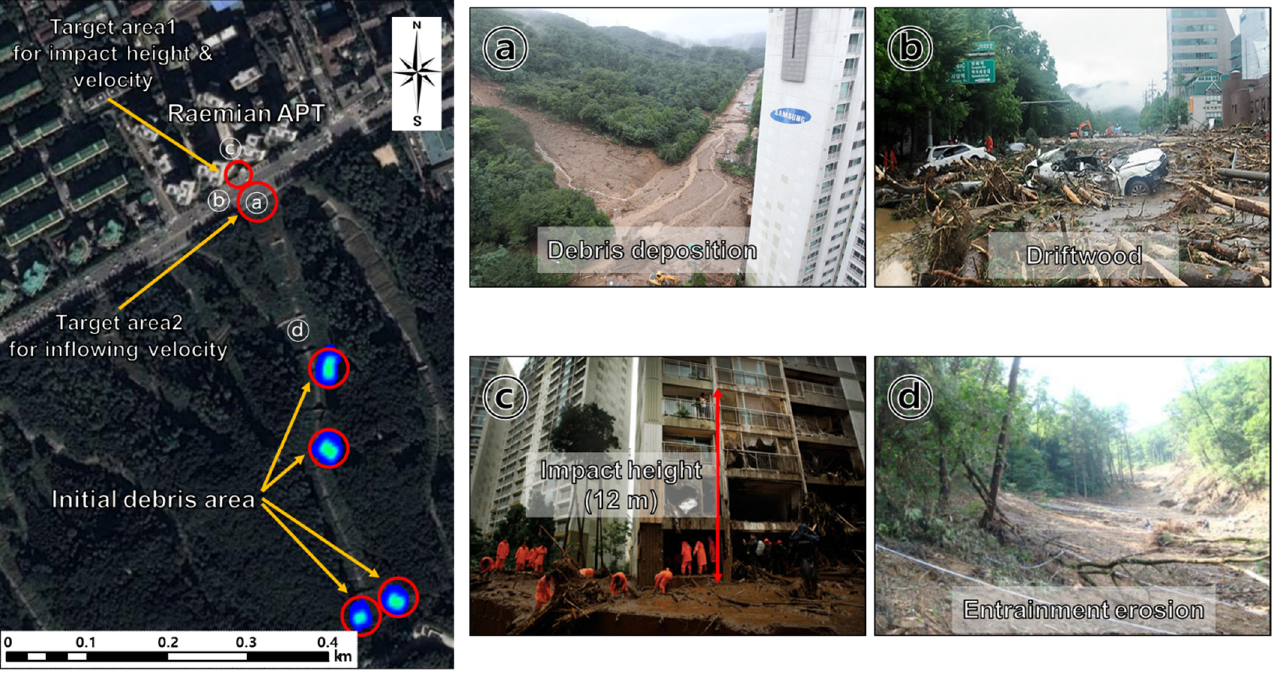
Figure 1. Study area and disaster situation of debris flow. ( a ) Debris-flow deposition [63], ( b ) drift- wood deposition [63], ( c ) impact height [64], and ( d ) entrainment erosion [62].